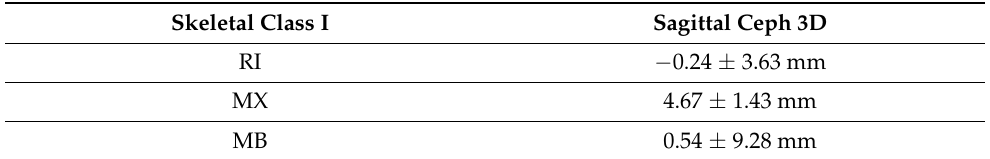
Table 4. Results obtained for Skeletal Class I following analysis employing the Sagittal Ceph 3D method.